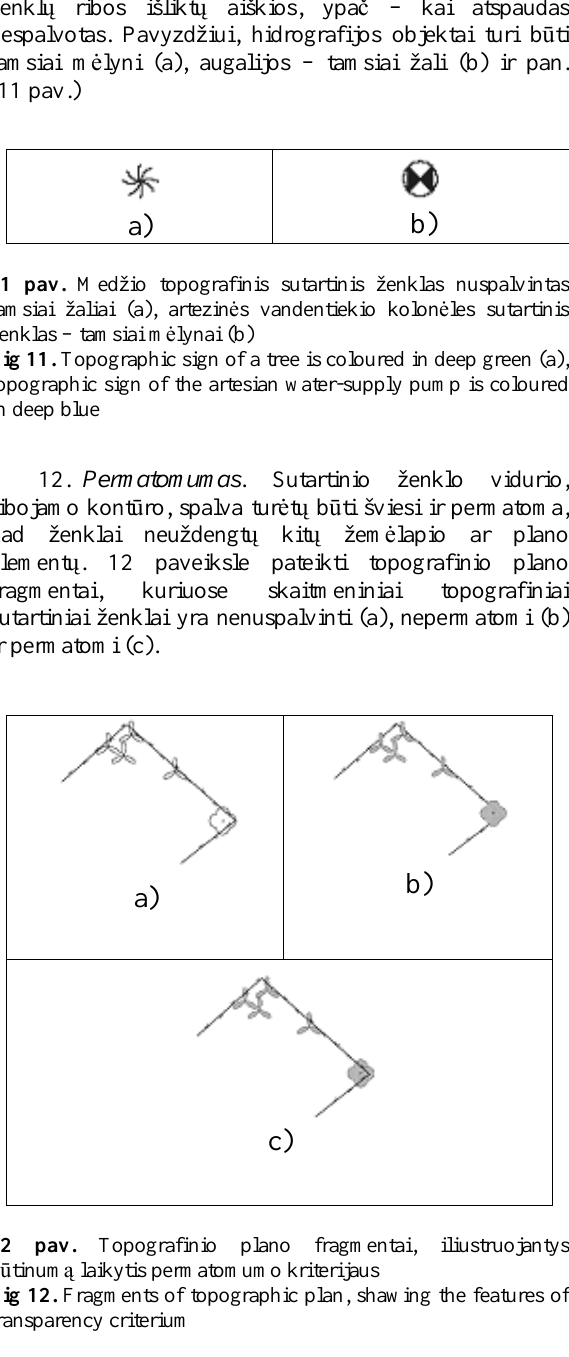
Fig 12. Fragments of topographic plan, shawing the features of transparency